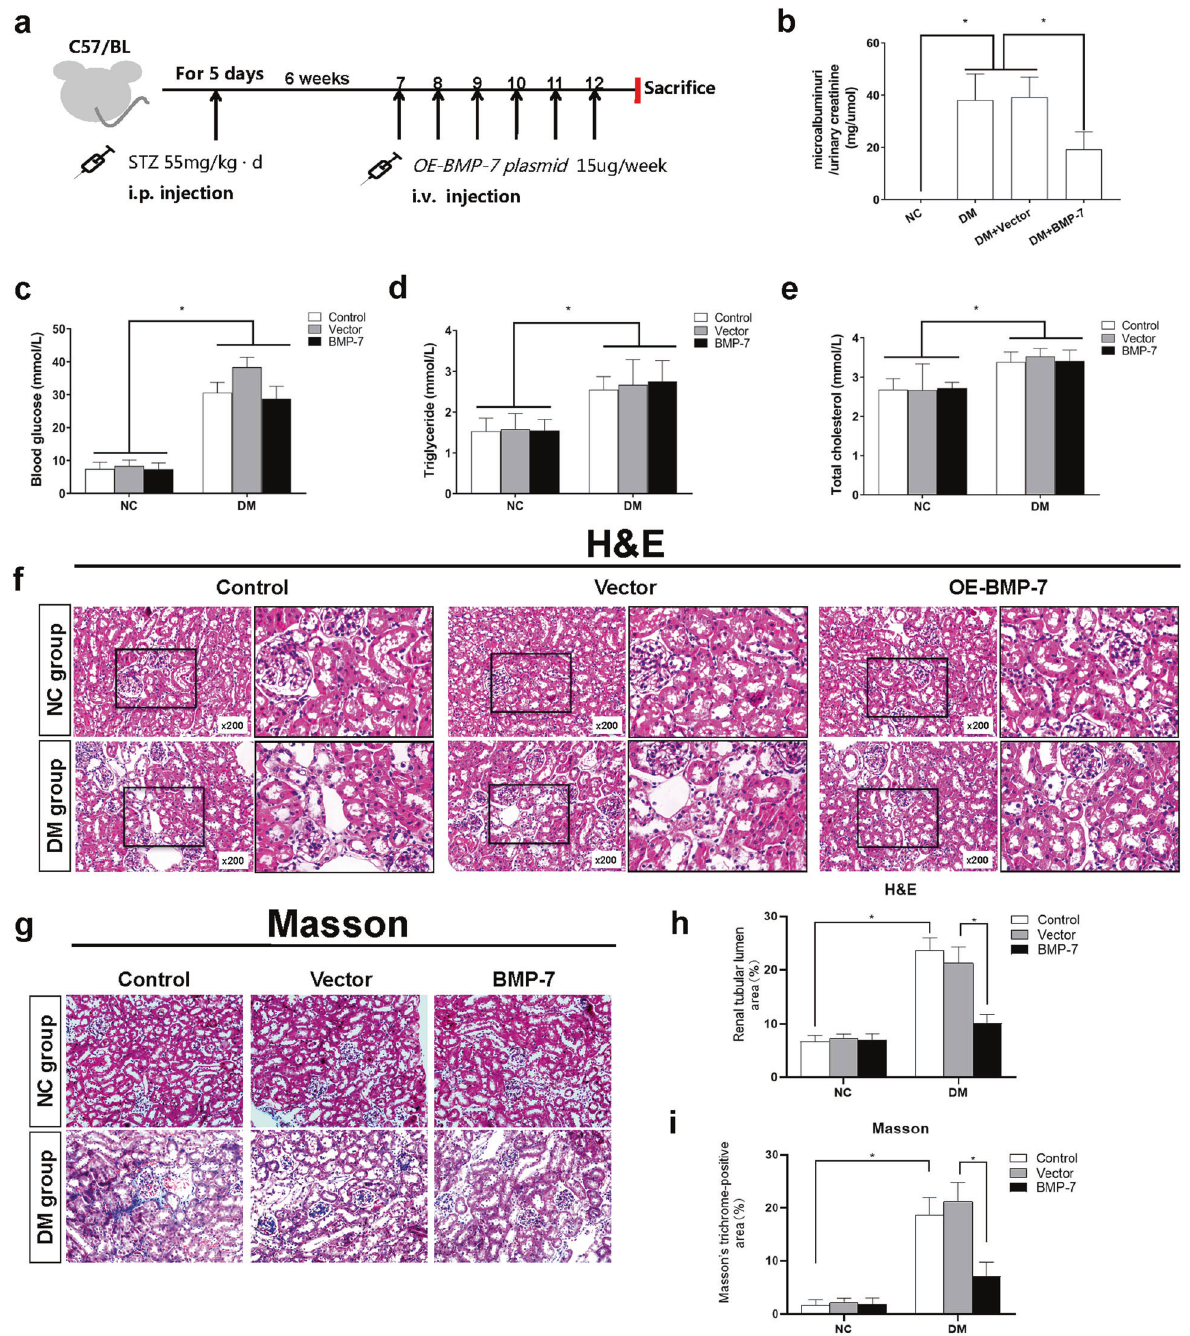
Fig. 1 BMP-7 ameliorated renal fi brosis in diabetic mice. a Rescue experiment design. At 6 weeks after the diabetic mice model had been successfully established, OE-BMP-7 plasmid was injected i.v. every week for 6 consecutive weeks, and mice were killed at the end of 12 weeks. b Urinary microalbumin/urinary creatinine level in NC + Control group and the DM group (DM + Control, DM + Vector, DM + BMP-7) mice, * P < 0.05 ( n = 6). c Blood glucose, d Triglyceride, e Total cholesterol levels in the NC group (NC + Control, NC + Vector, NC + BMP-7) and DM group (DM + Control, DM + Vector, DM + BMP-7) mice,* P < 0.05 ( n = 6). Histological changes of kidneys in the NC group and DM group f (hematoxylin-eosin staining), g (Masson ’ s trichrome staining)black box indicates the enlarged area of details for fi brosis(magni fi cation ×400). h Renal tubular lumen area was analyzed in each group from six random fi elds (200×), * P < 0.05 ( n = 6). i Positive staining density of Masson ’ s trichrome staining was analyzed in each group from six random fi elds (200×), * P < 0.05 ( n = 6). compared to the control group or vector group in diabetic mice. Smad1/5 (p-Smad1/5 ( ser463/465) ) in vivo and in vitro. As shown in Similar to the in vivo results, a signi fi cant decrease was detected in Fig. 5a, b, p-Smad1/5 ( ser463/465) level was reduced during the p-Smad1/5 ( ser463/465) level in NRK-52E cells exposed to high- development of DKD in the control group and vector group in vivo. In contrast, in diabetic mice injected with OE-BMP-7 glucose (Fig. 5c, d). As expected, BMP-7 maintained p-Smad1/ plasmid, p-Smad1/5 ( ser463/465) level was partially elevated 5 ( ser463/465) level in NRK-52E cells under high-glucose co-treatment Cell Death and Disease (2022)